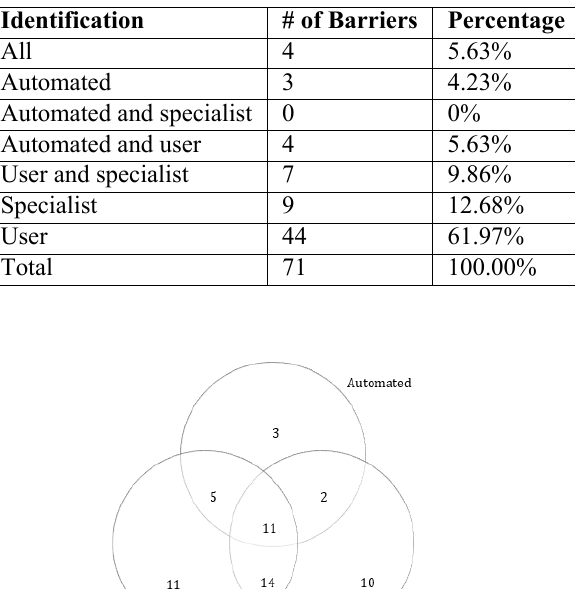
Table 9. Problems found on the mobile platform